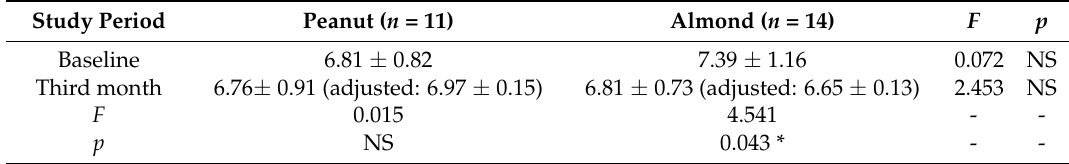
Table 4. Comparison of glycated hemoglobin (%) between the two groups.